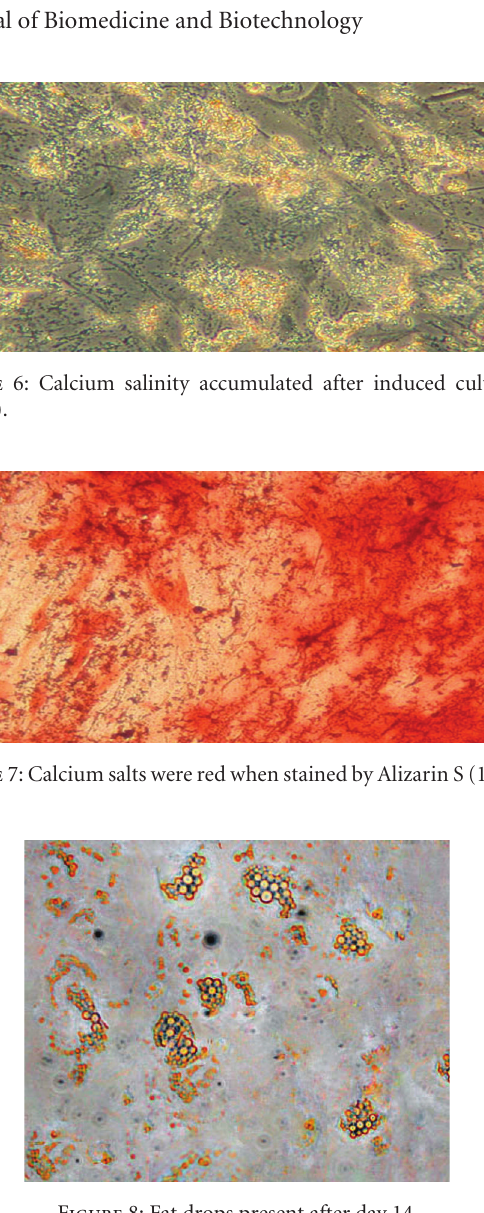
Figure 8: Fat drops present after day 14.